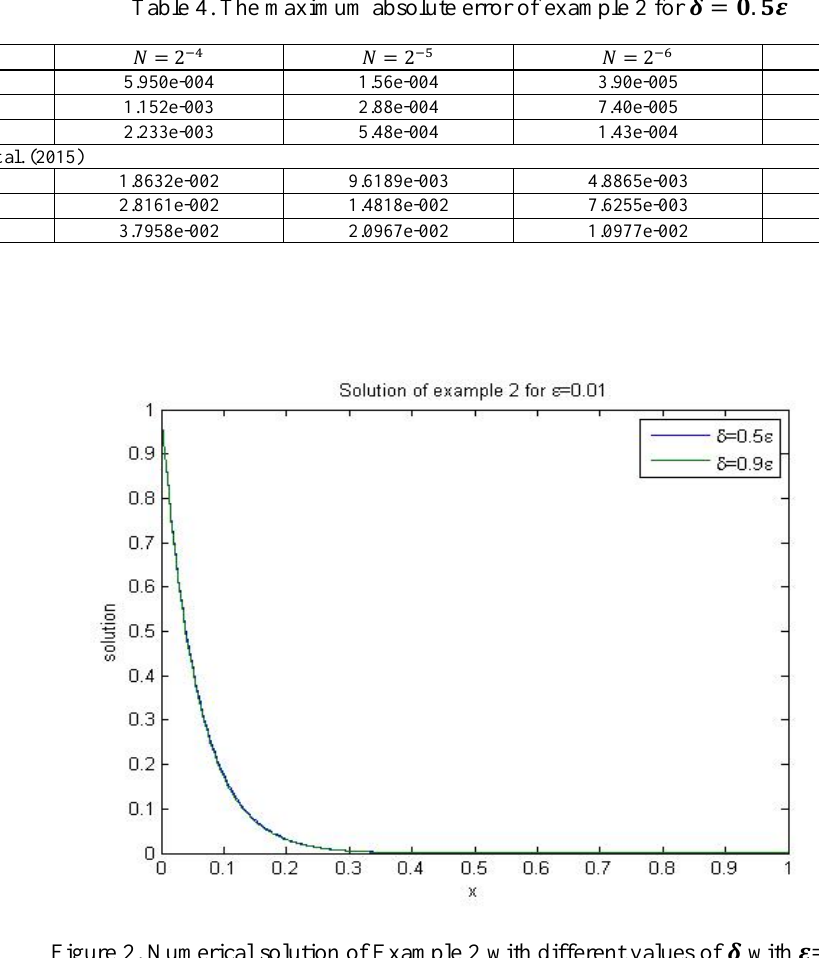
Figure 2. Numerical solution of Example 2 with different values of 𝜹 with 𝜺